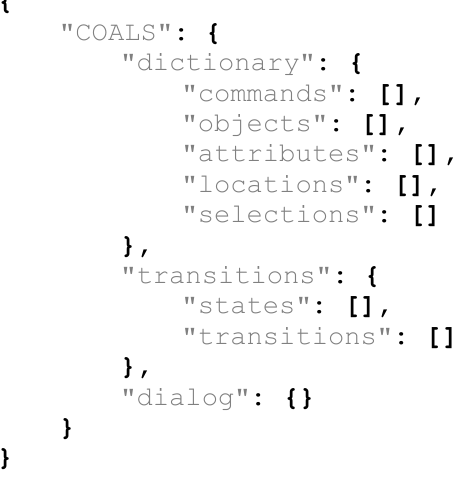
Figure 2: General Framework’s